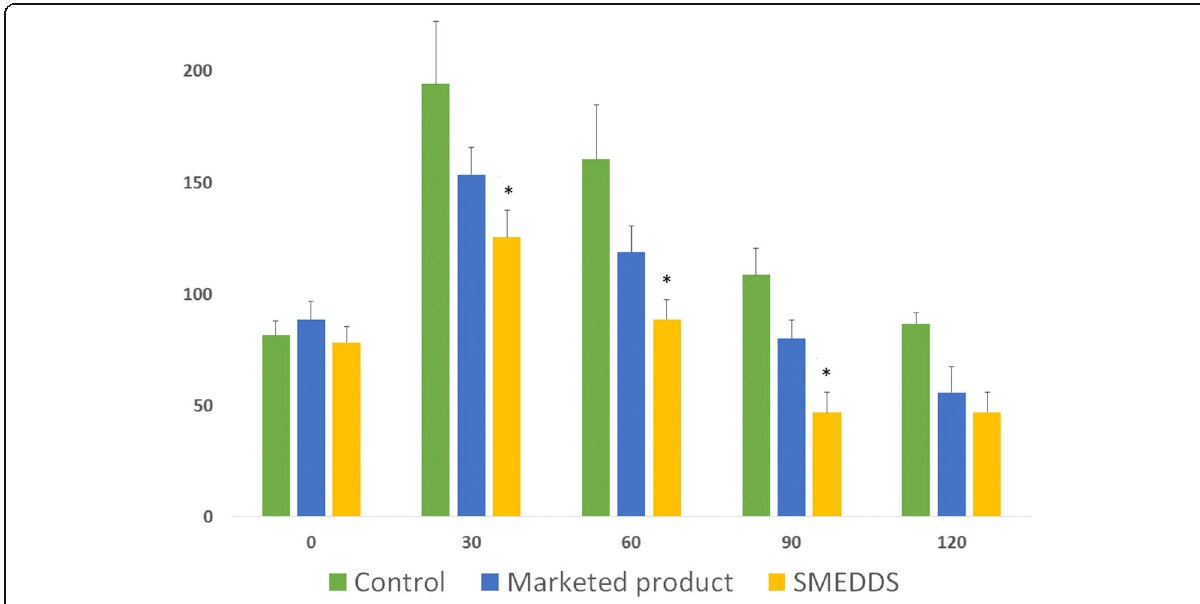
Fig. 6 Comparison of in vivo hypoglycemic effect of SMEDDS pellet with the marketed